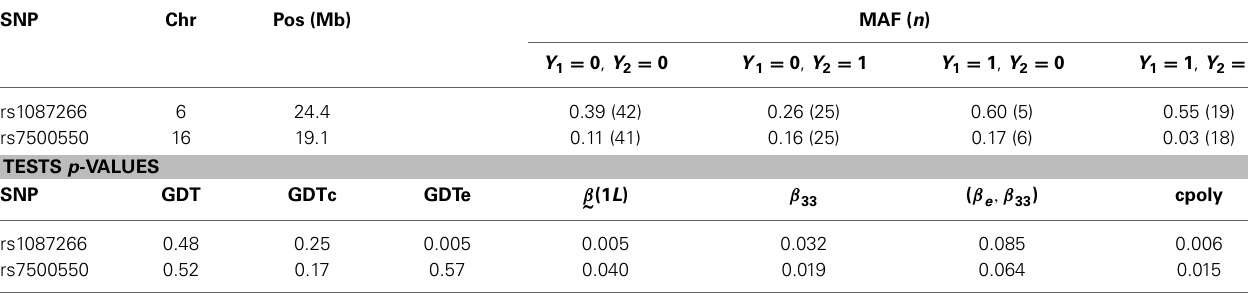
Table 4 | Results for SNPs where a p -value < 0 . 05 was obtained in at least one analysis a